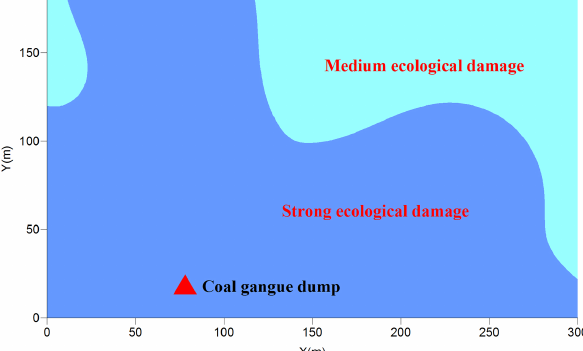
Figure 5. The map of potential ecological damage distribution of soil around the coal gangue dump (the red triangle represents the coal gangue